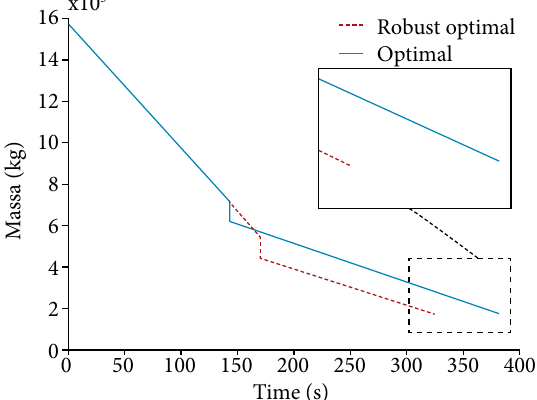
Figure 13. Comparison of mass in optimal and robust optimal.